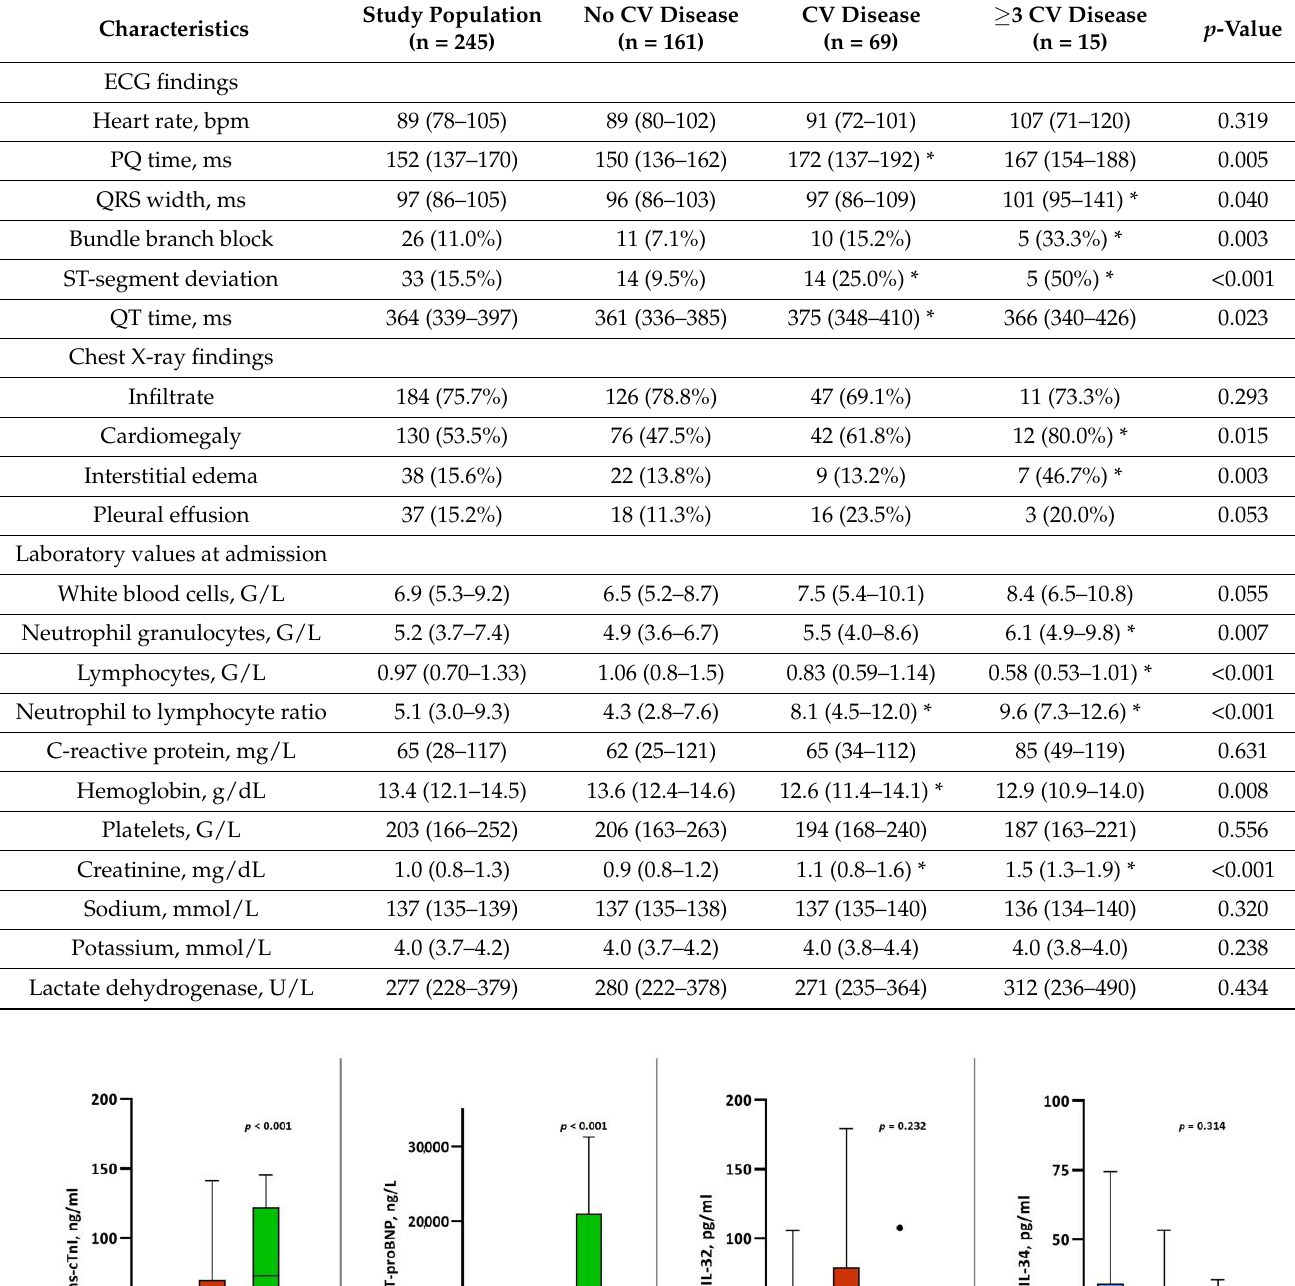
Table 2. Diagnostic findings of the study population stratified by CV disease. * indicates a significant difference to those without CV disease after Bonferroni correction.